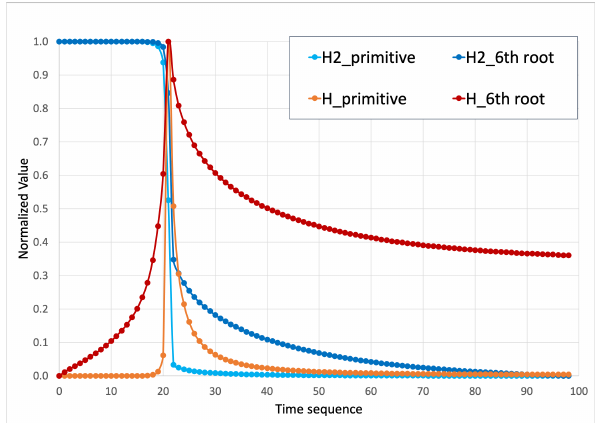
Figure 2. Illustration of different nonlinear transformations on a major and minor species. The 6th root transformation allows the low concentrations of both to be visible to the